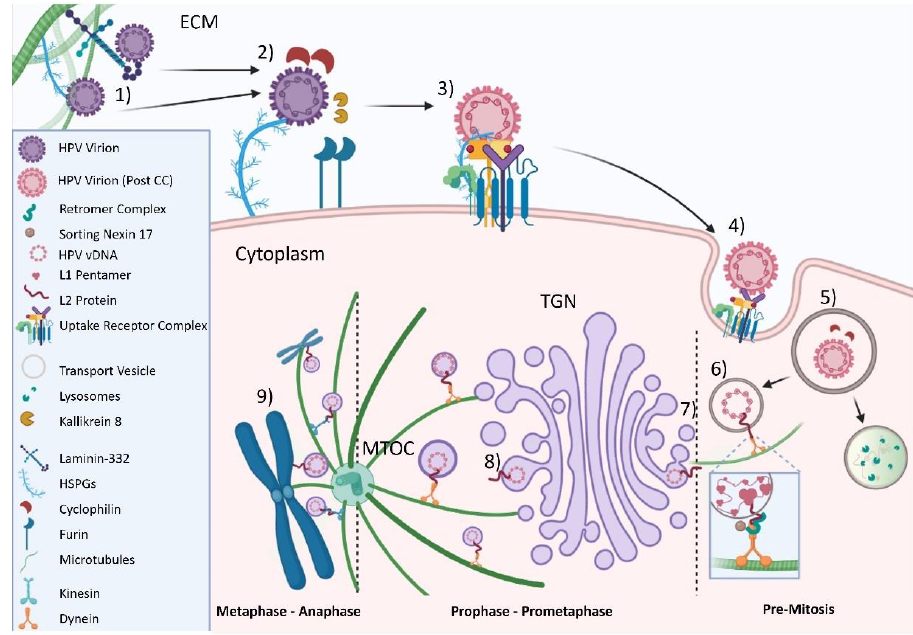
Figure 1. Schematic diagram of the late cytosolic trafficking events and nuclear delivery of incoming HPV16 genome. ( 1 ) Attachment of HPV virion to HSPGs on the extracellular matrix (ECM) with serine protease kallikrein 8 (KLK8) facilitating extracellular cleavage of L1. ( 2 – 3 ) Conformational changes in both L1 and L2 proteins. ( 4 ) Virions and uptake receptors internalized into cell. ( 5 ) Viral capsid uncoated; cyclophilin releases L1 and L2 afterwards. ( 6 ) L2 protein penetrates intercellular membrane and interacts with cytosolic factors. ( 7 – 8 ) Prophase-pro-metaphase: vesicles containing HPV genome dissociate from TGN and assemble on astral microtubules (MTs) to microtubule-or- ganizing center (MTOC). ( 9 ) Metaphase -anaphase: vesicles assemble on spindle microtubules and travel to condensed chromosomes via (presumably) kinesin(s). Adapted from [1] and created with BioRender.